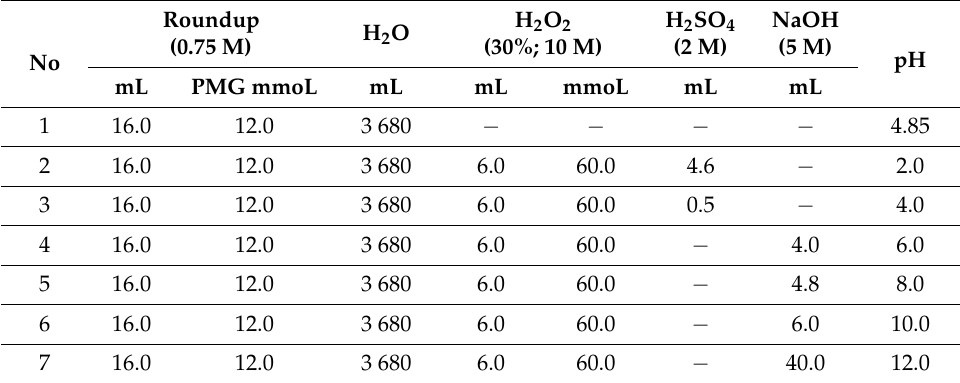
Table 4. Preparation of the reaction mixtures for AOP degradations of PMG in Roundup